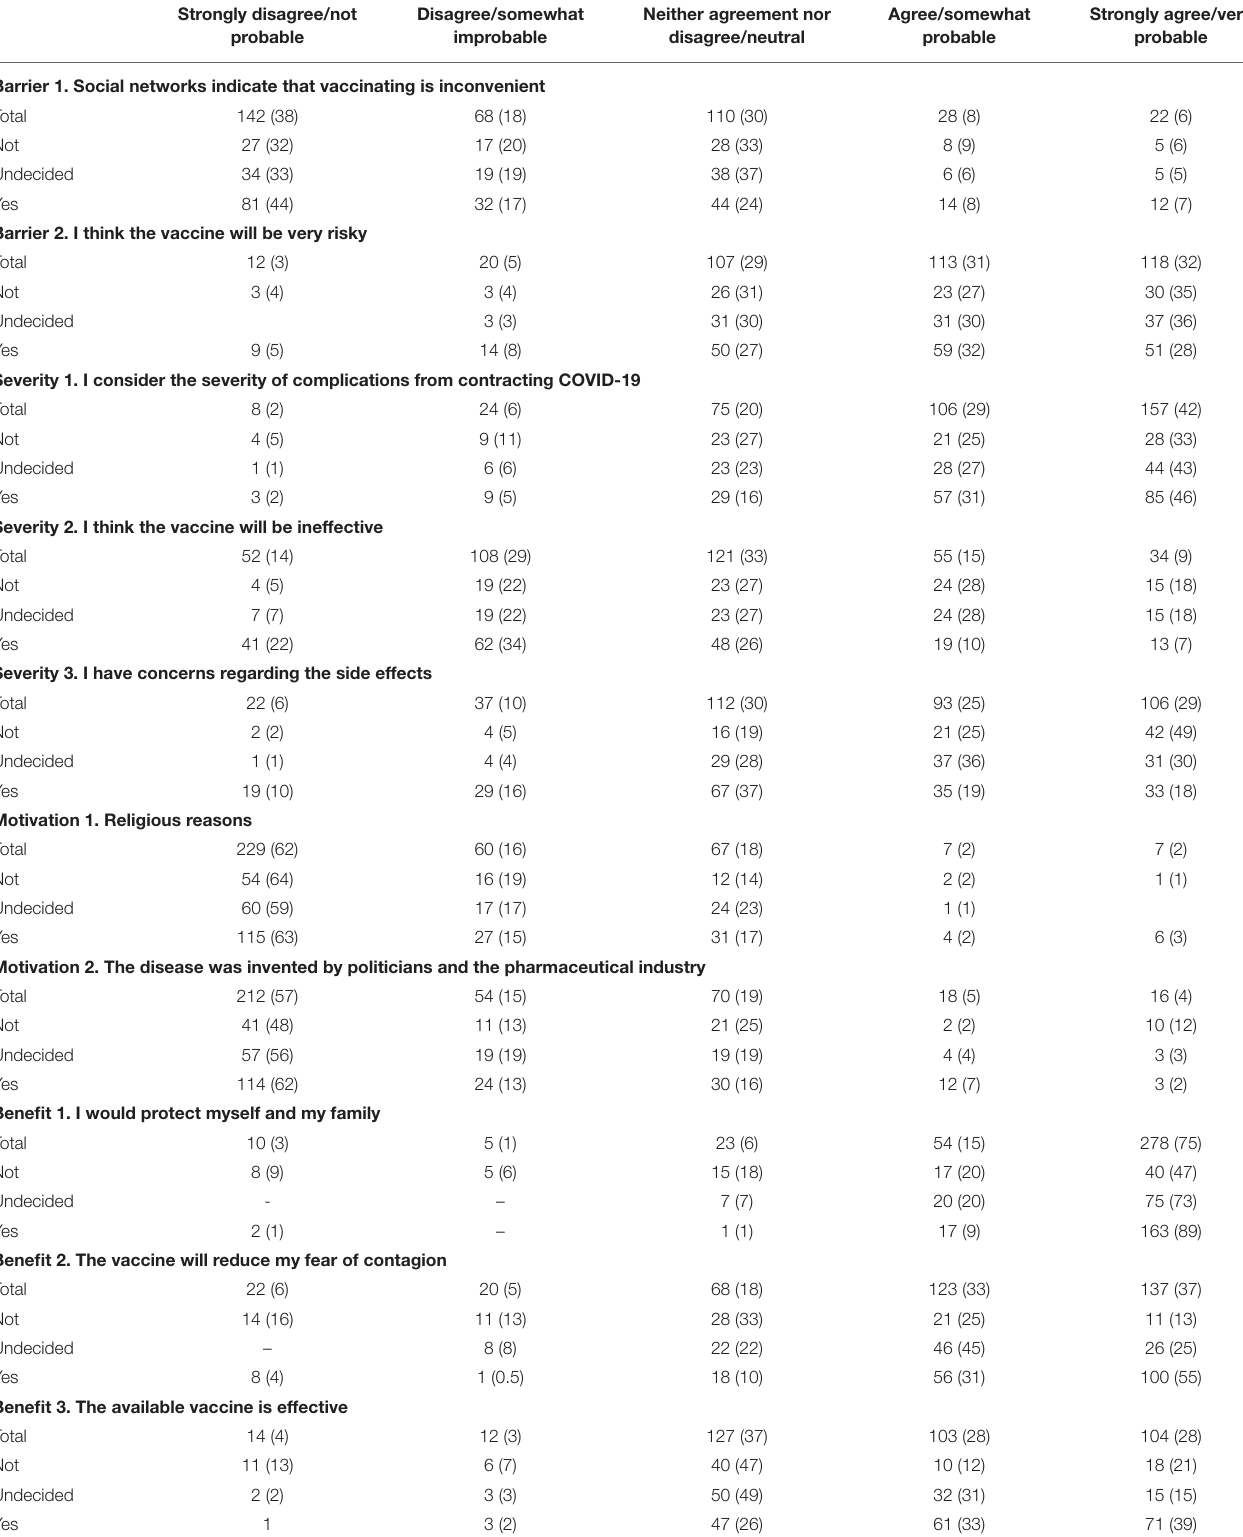
Agree/somewhat Strongly agree/very probable probable